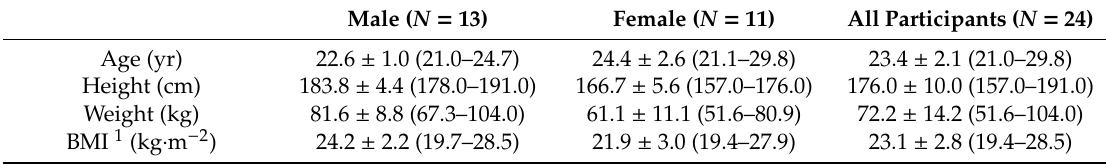
Table 1. Physical characteristics of participants. Values are mean ± SD (range).